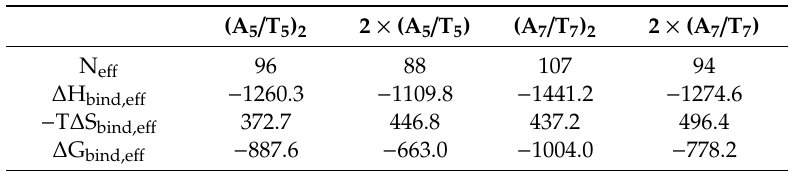
Table A3. Synergistic e ff ect of the dimeric ssiRNA concatemerization on their G 5 TEA-core PAMAM dendrimer e ff ective binding thermodynamics with respect to the corresponding monomeric ssiRNAs. Data from Tables A1 and A2. All values are in kcal /